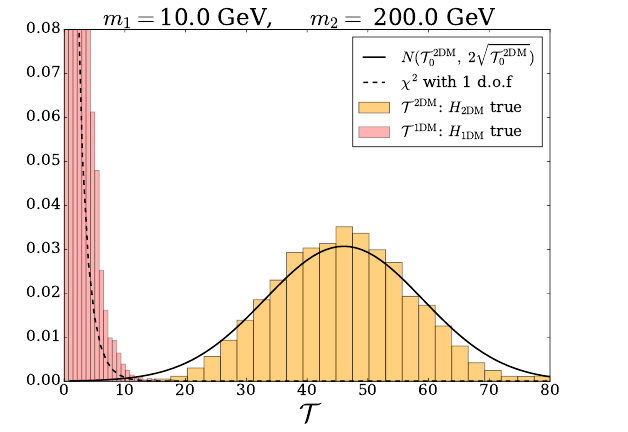
Figure 2. Normalised probability distribution of the test statistic T in a Xe target for true one- component T 1DM (light red) and two-component T 2DM (light yellow) DM hypothesis. We fixed m 1 = 10 GeV and m 2 = 200 GeV. We used 8500 samples. We see that the one-component DM follows a χ 2 dis- tribution with one degree of freedom, while the two-component DM hypothesis is well-approximated by a Gaussian centered at T 2DM